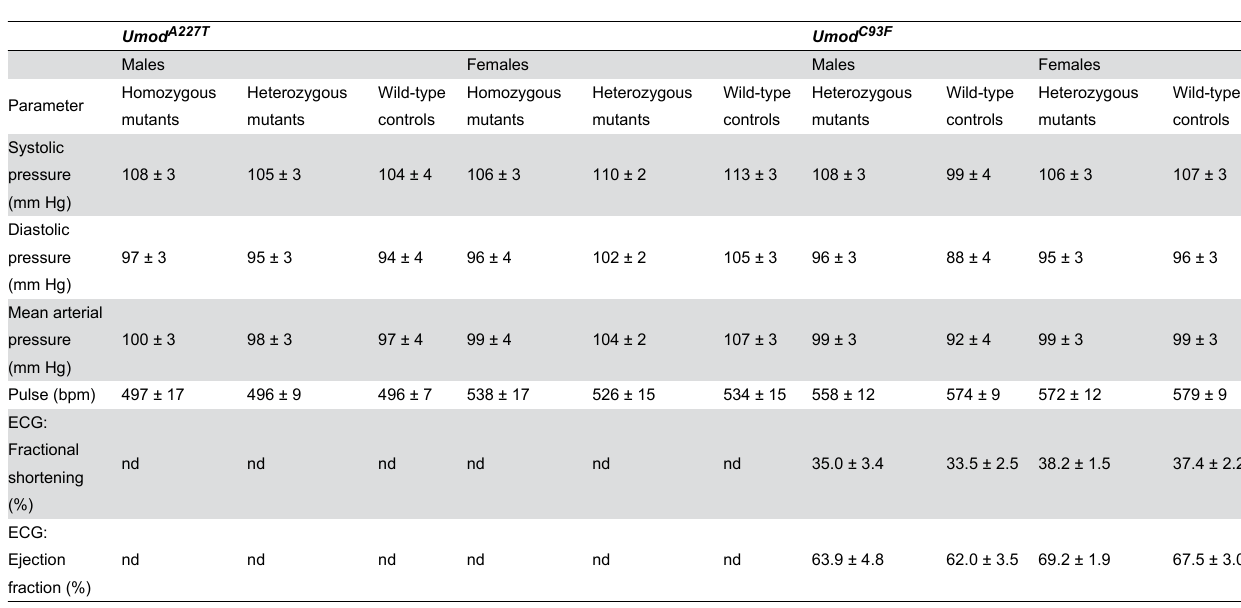
Table 4. Cardiovascular analysis of the lines Umod A227T and Umod C93F